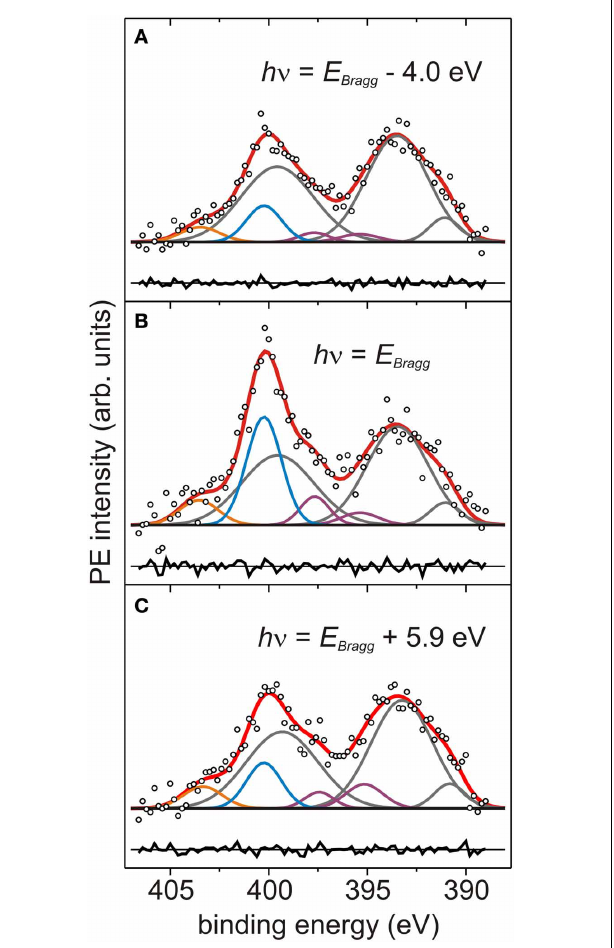
FIGURE 3 | Photoelectron spectra at different photon energies. (A–C) N1 s + Ag3 d -plasmons XSW-PE spectra of AB/Ag(111) measured at the photon energies h ν reported in each panel (with E Bragg = 2634eV). Each PE spectrum is normalized to the corresponding background value at 388eV. Symbols and color code as in Figure 2